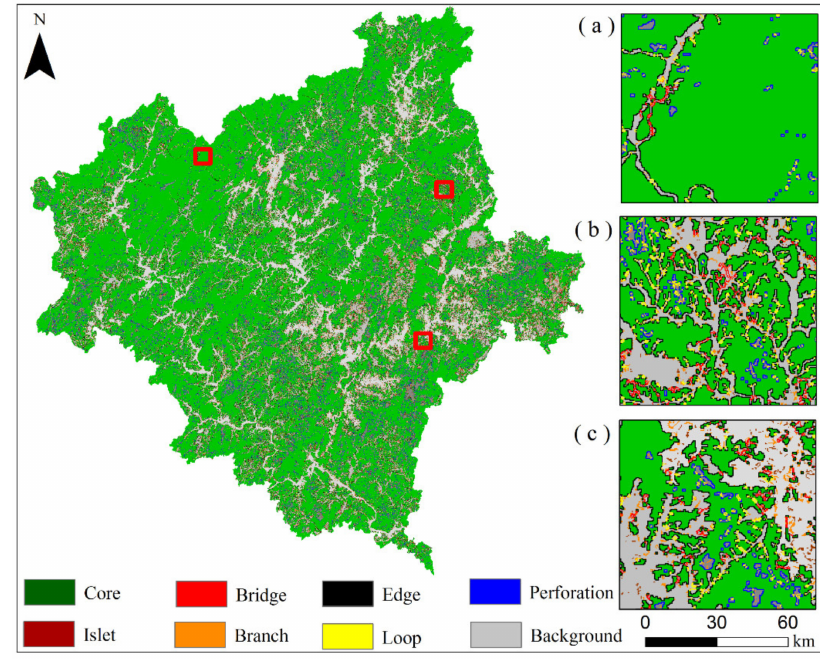
Figure 2. ( a – c ) Spatial distribution of landscape pattern based on MSPA. Table 2. Statistical areas of each landscape